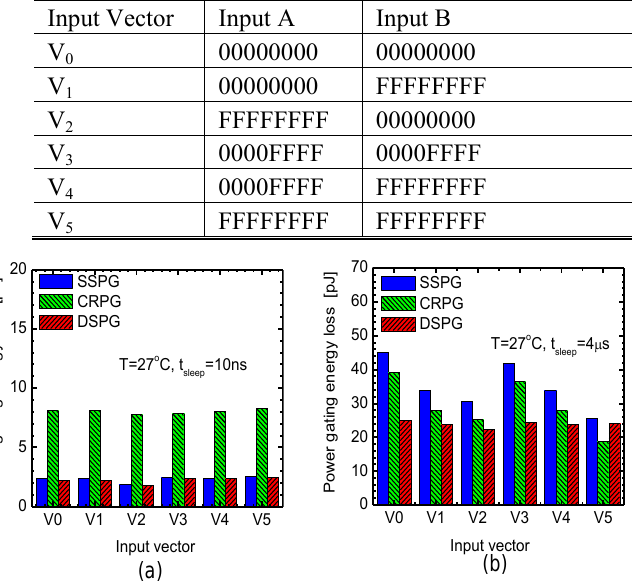
Figure 6 . (a) Power-gating energy loss of the 32-bit Carry-Look-Ahead adder when the sleep time is as short as 10ns for the 45-nm PTM, V =1.1 V, and DD W /W =10%. The DSPG consumes almost the PG Logic Table 2 : Comparison the normalized leakage power loss in ISCAS-85 benchmark circuits when sleep time is from 0.01µs to 5µs at 27 o